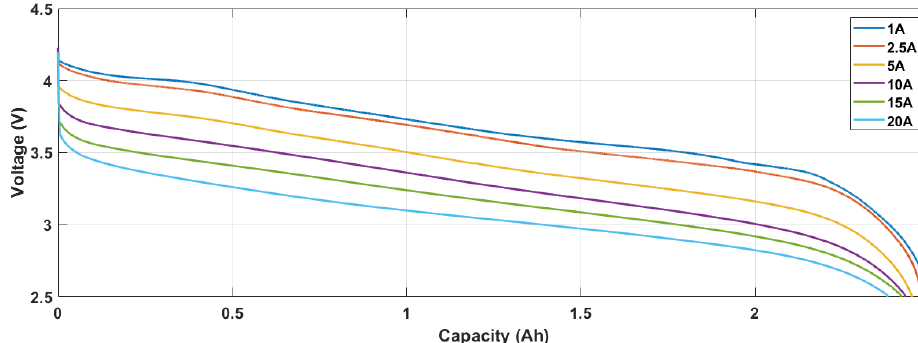
Figure 7. Discharge characteristics for SoH = 100%.